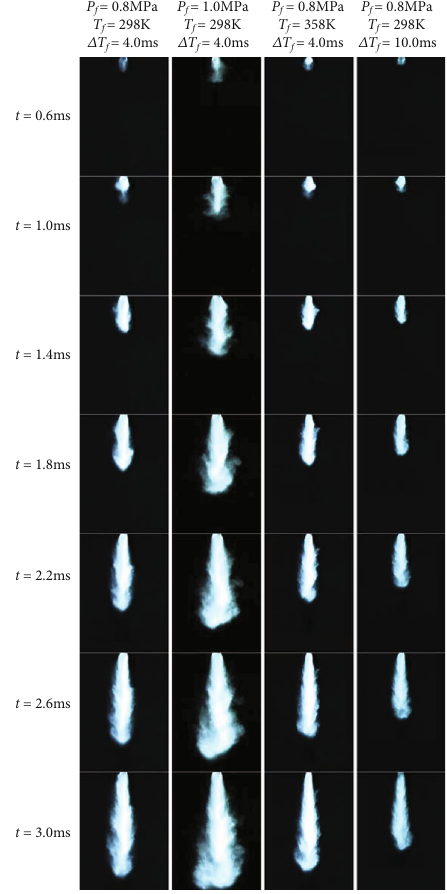
Figure 20: The spray development of the four test conditions during the fuel-air mixture injection